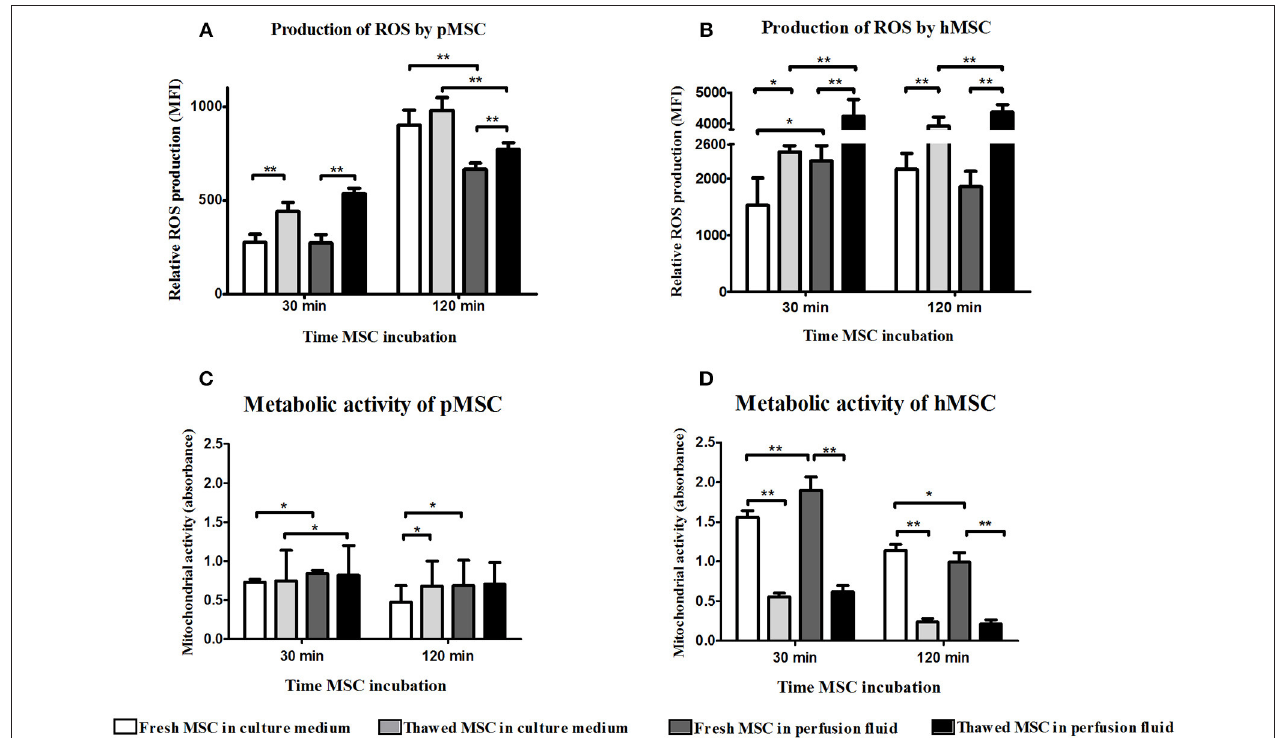
FIGURE 3 | Perfusion fluid and thawing after cryopreservation increase ROS production and reduce metabolic activity in MSC. (A) ROS production in fresh and frozen-thawed pMSC suspended in culture medium or in perfusion fluid. (B) ROS production in fresh and in frozen-thawed hMSC suspended in culture medium or in perfusion fluid. (C) Metabolic activity measured by XTT reduction by NADH of fresh and frozen-thawed pMSC after 30min and 2h incubation in perfusion fluid. (D) Metabolic activity measured by XTT reduction by NADH of fresh and frozen-thawed hMSC after 30min and 2h incubation in perfusion fluid ( n = 5). Results are shown as means ± SD. * p < 0.05; ** p <